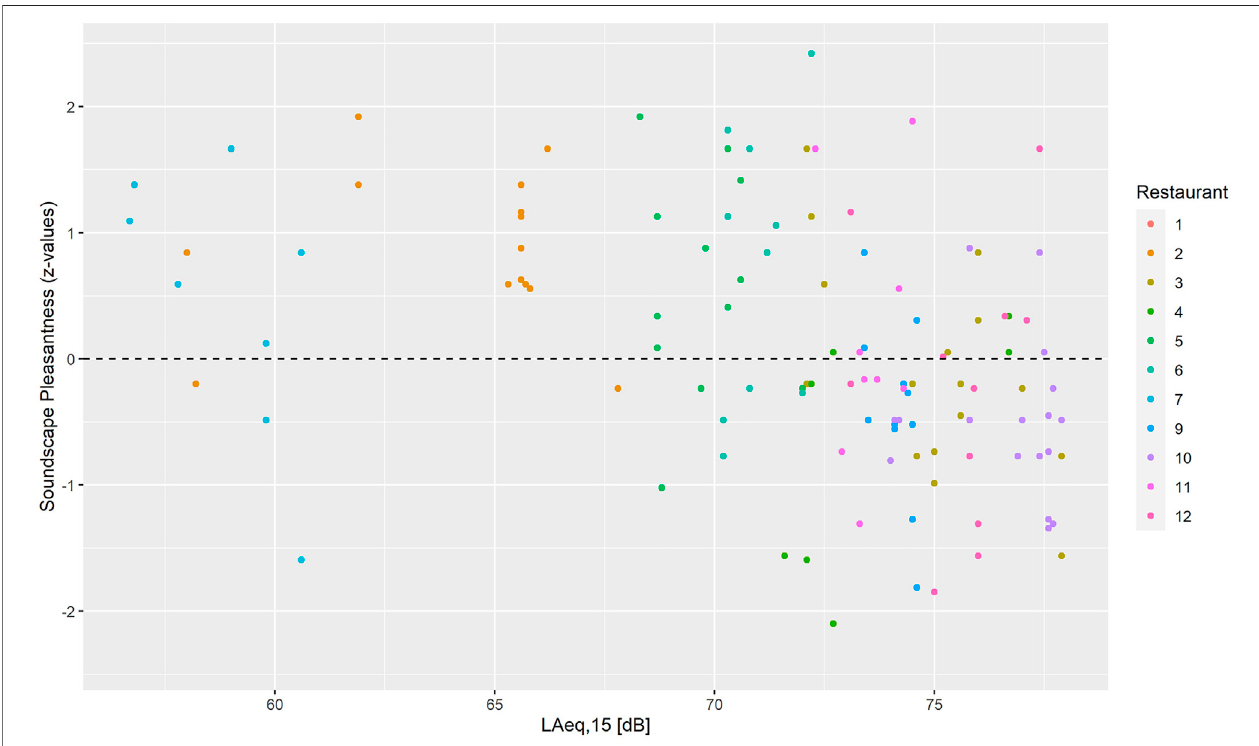
FIGURE 2 | L A,eq,15 values and z-standardized soundscape pleasantness judgements.